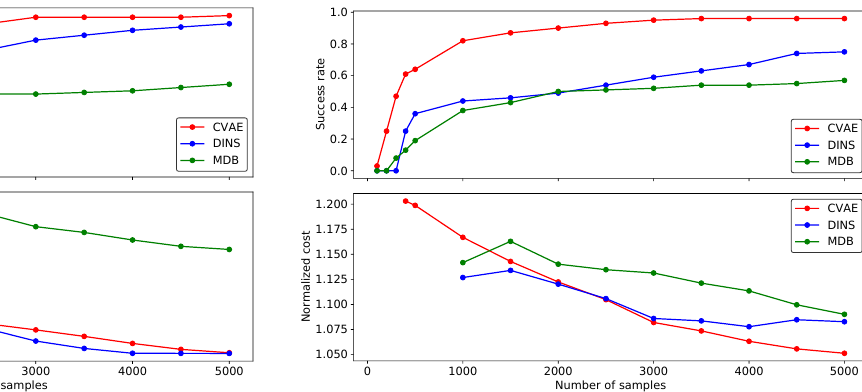
Figure 9: Comparison of the convergence rate when the starting point is beyond human experience in the Trondheim